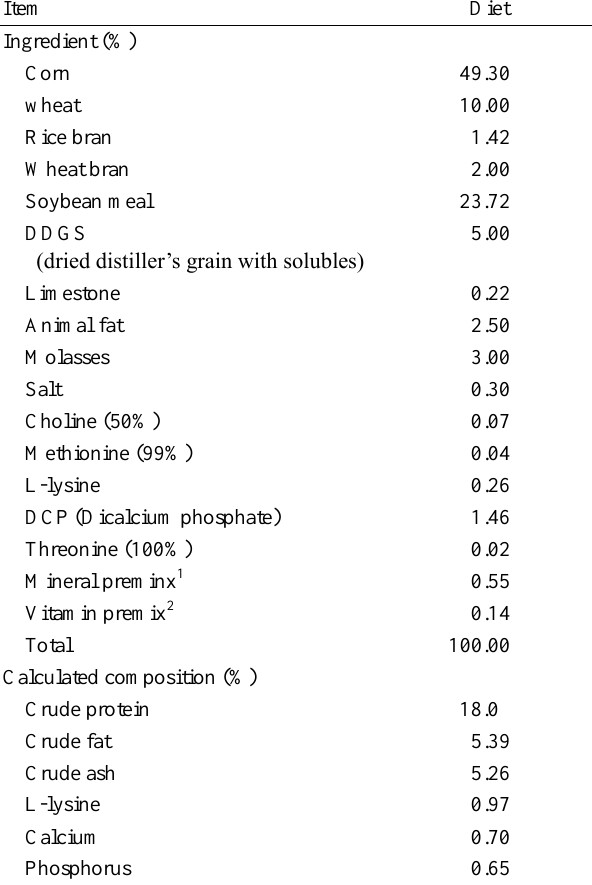
Table 1. Feed composition of control diet (as-fed